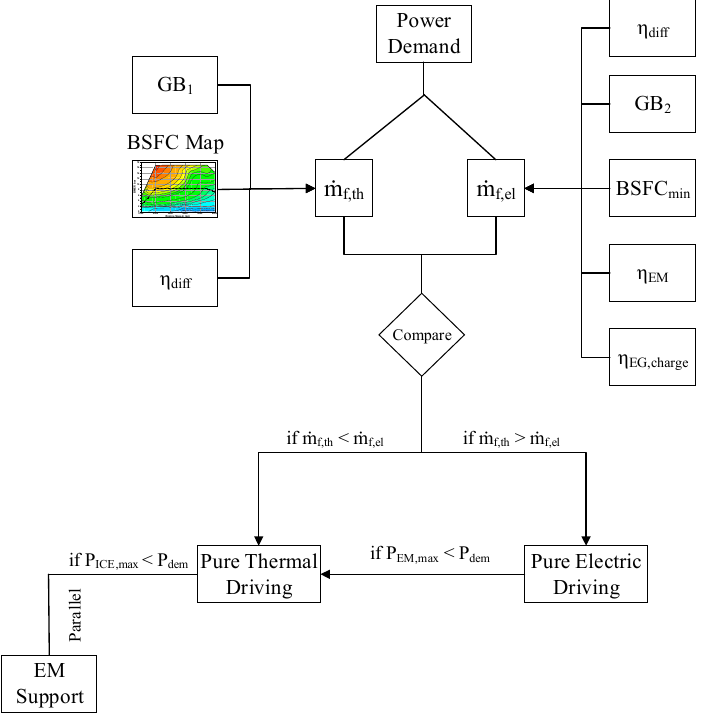
Figure 6. Flowchart that schematizes the ETESS logics.